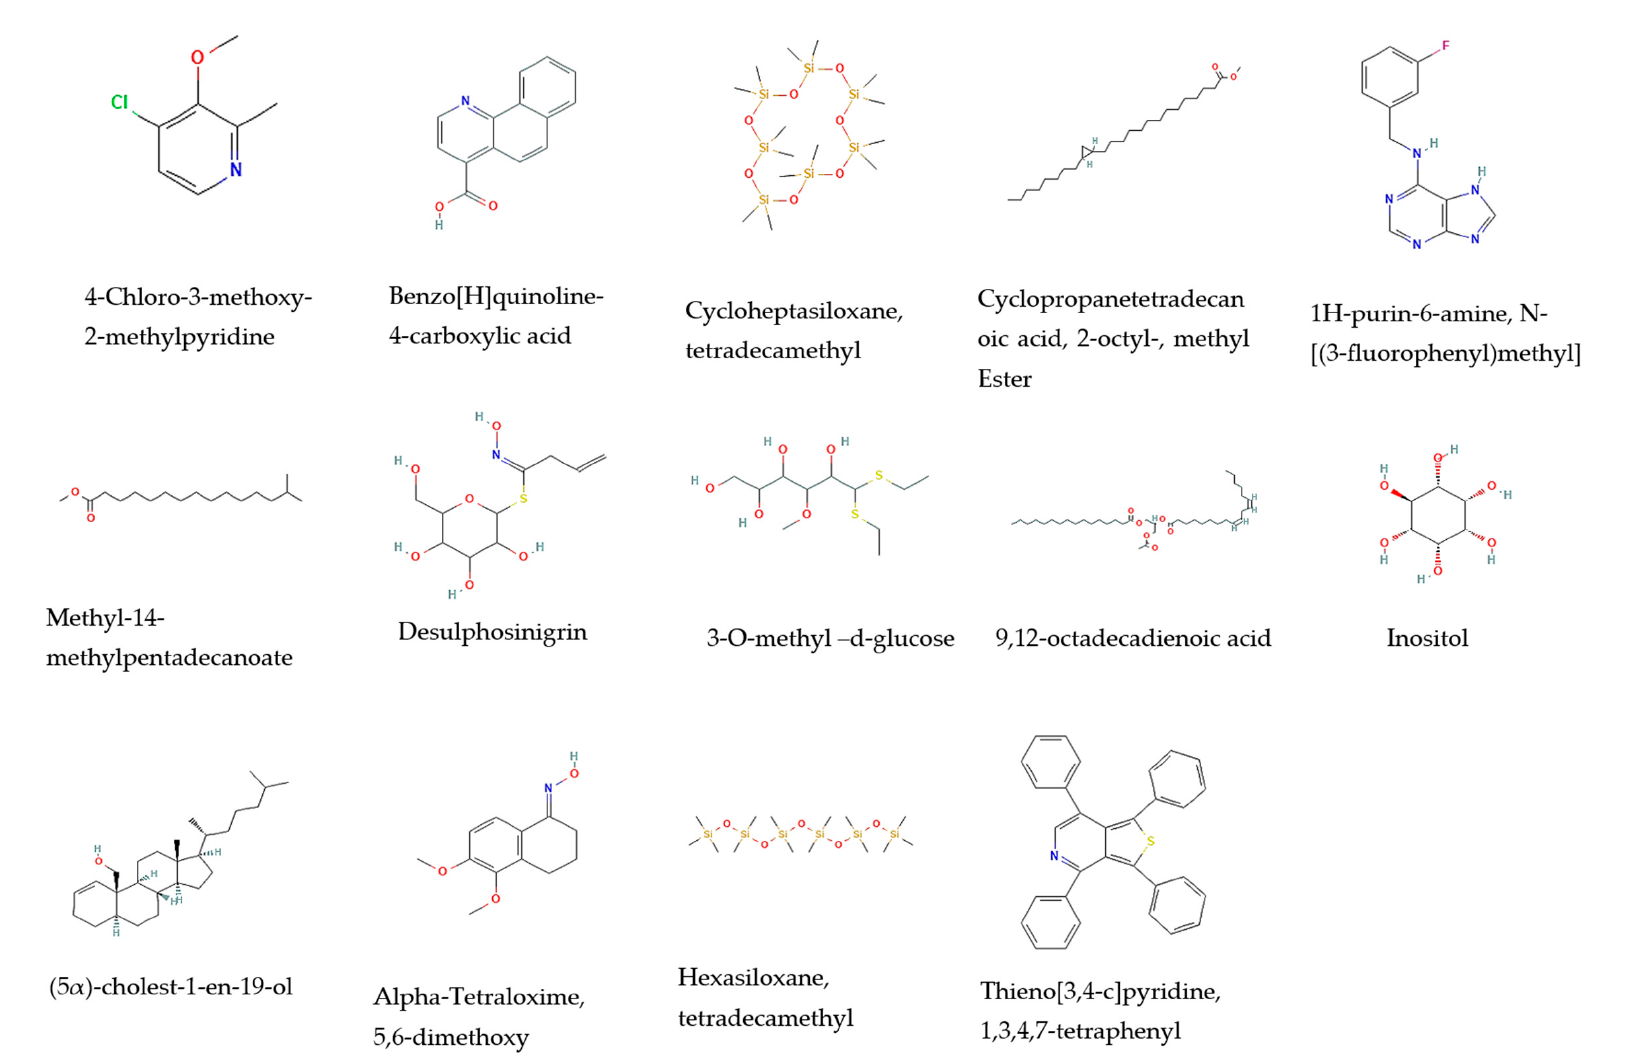
Figure 1. The chemical structures of the chemical compounds identified from methanol extracts from the leaves and stems of Rhizophora mucronata via GC/MS.